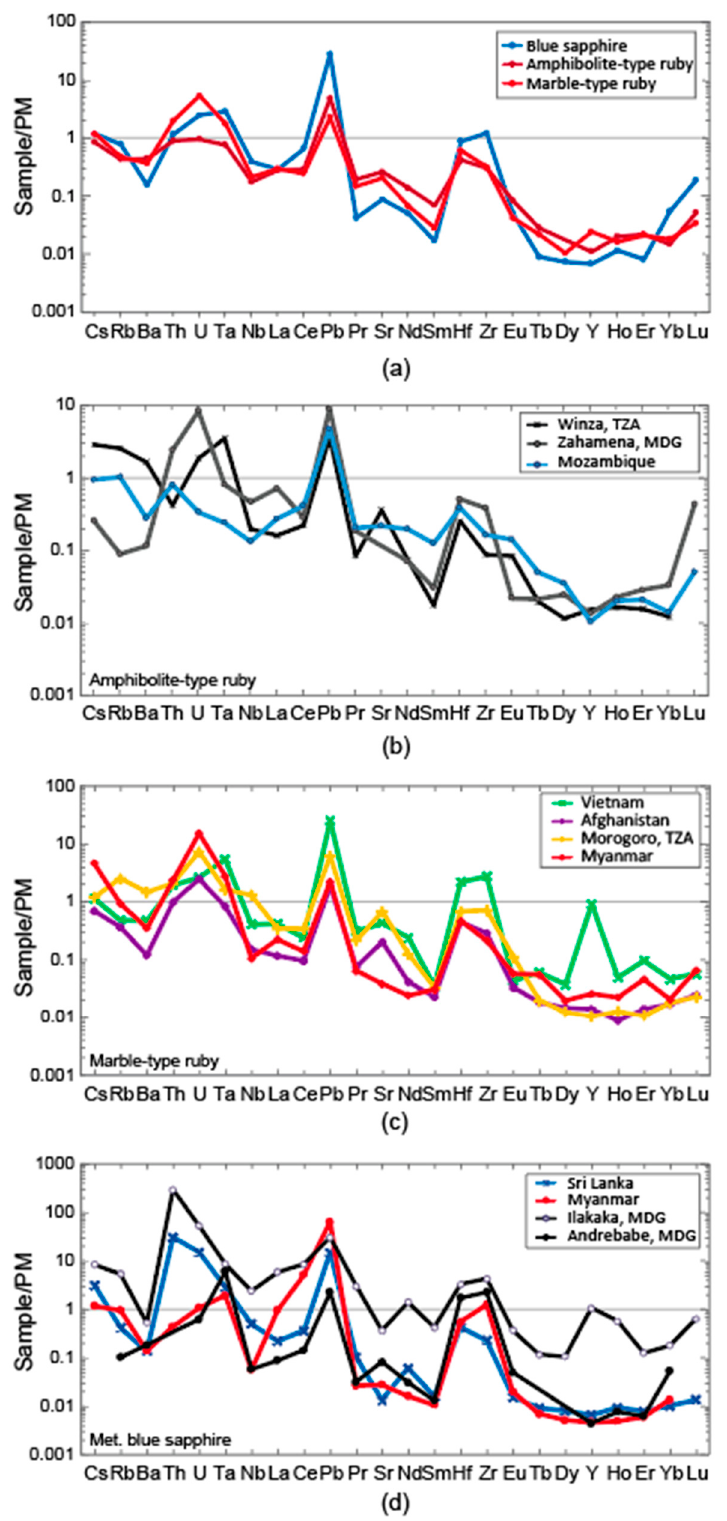
Figure 3. Primitive mantle (PM)-normalized [58] median trace element concentrations in ( a ) the three different deposit groups, ( b ) the amphibolite-type ruby localities, ( c ) the marble-type ruby localities, and ( d ) the localities of metamorphic blue sapphire analyzed by offline ablation followed by solution inductively coupled plasma mass spectrometry (ICPMS) in this study. All data plotted are >limit of quantification (LOQ). TZA, Tanzania; MDG, Madagascar.